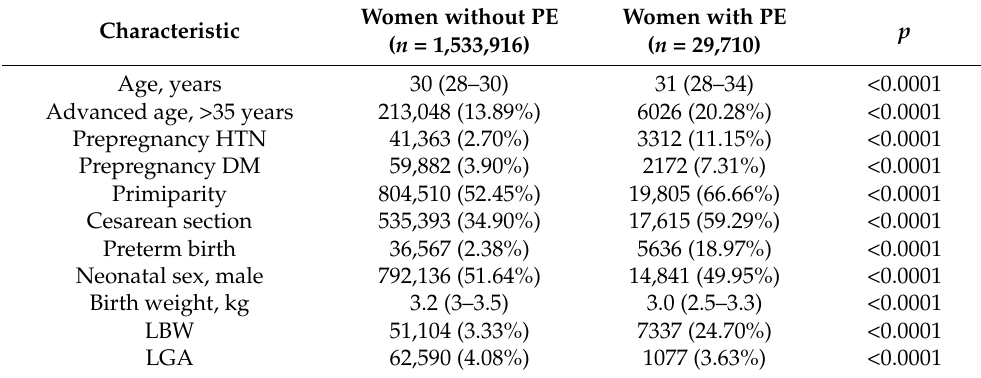
Table 1. Prepregnancy and pregnancy characteristics stratified according to maternal preeclamp- sia (PE).